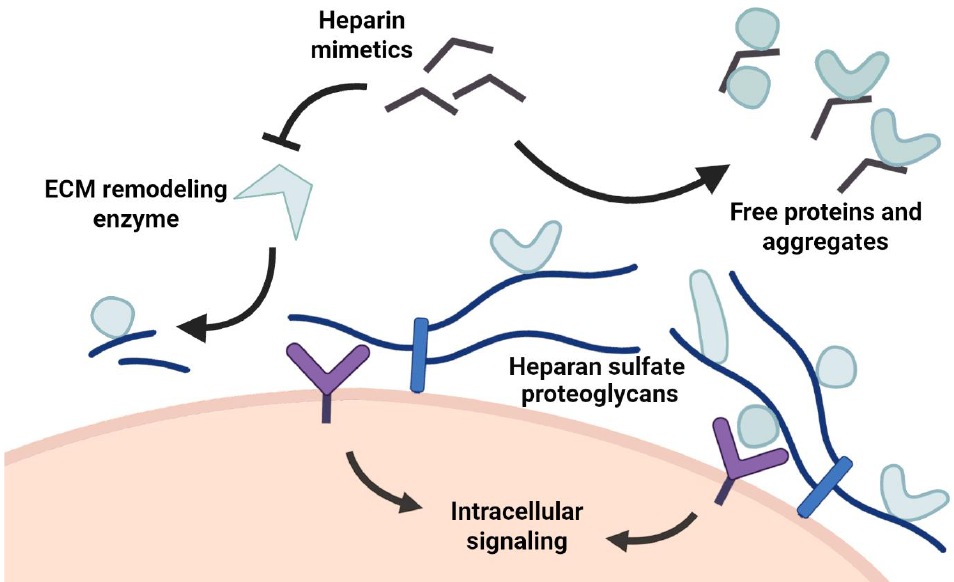
Figure 2. Heparin mimetics affect various biochemical mechanisms in the extracellular matrix. Heparin mimetics inhibit extracellular remodeling enzymes such as Heparanase and impact regular remodeling pathways and structural integrity. Heparin mimetics can also bind to heparan sulfate binding proteins and change protein concentration levels near the cell surface. Both of these mechanisms cause an eventual change in intracellular signaling, which might affect cell homeostasis. Beyond the direct effects of heparin mimetics on enzymes and signaling proteins, changes that affect general protein–heparan sulfate interactions and protein assemblies In any case, the underlying disease mechanisms in relation to heparan sulfate or hep- can alter signaling behavior. An example of this is the antagonist removal from the imme- arin dependence have to be examined in order for appropriate drug development to diate surroundings of a cell surface [41,66], which can be induced by free heparin-based molecules that outcompete regular heparan sulfate binding [67,68]. This would result in free diffusion of the signaling protein and dissolve concentration gradients, resulting in serious consequences, as biochemical regulation mechanisms would be lost. Nonetheless, increased stability of heparan sulfate-bound proteins has also been shown to affect signal- ing; biomaterials that contained heparin were able to induce osteogenesis by stabilizing BMP signaling proteins around cellular surfaces [69]. Studies such as these illustrate the